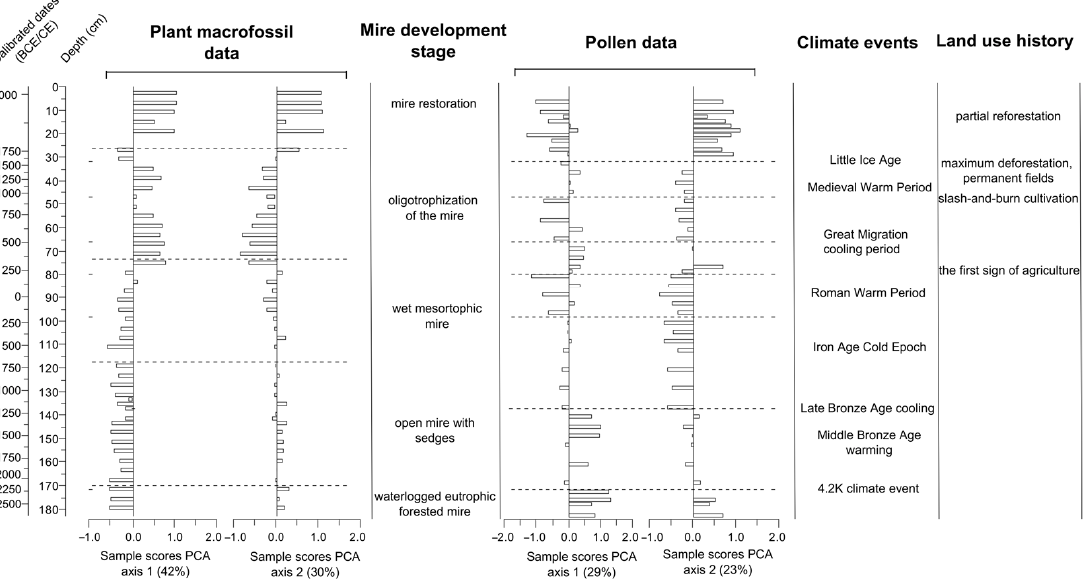
Figure 9. The results of Principal Component Analysis (PCA) of plant macrofossil and pollen data with the main periods of mire, climate and landscape dynamics. BCE—Before Common Era, CE—Common Era.